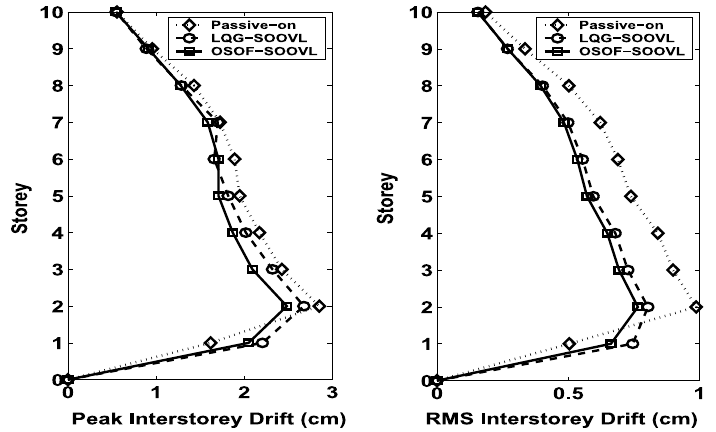
Fig. 4. Storeywise peak and RMS inter-storey drifts.